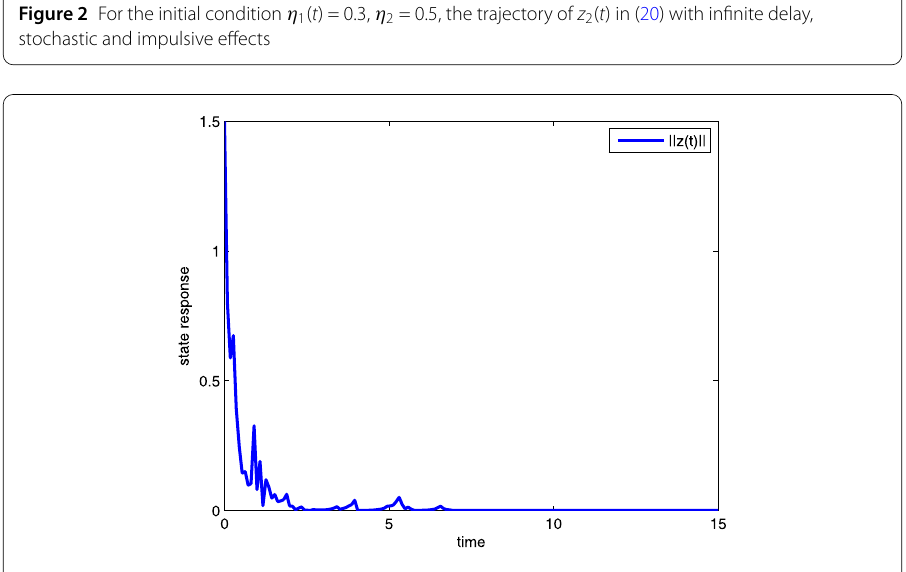
Figure 3 Trajectory of the second moment of